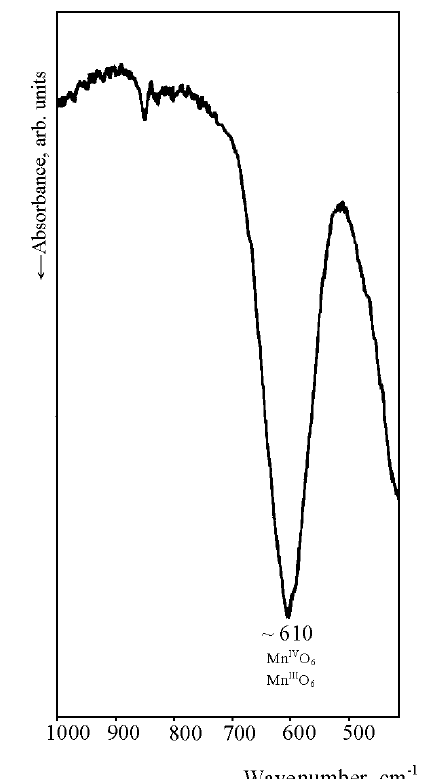
Fig. 6 IR-spectrum (1000-400 cm − 1 ) of the final product, obtained after heating of the complex LaMn(Cl)Cit-120 for 2.5 h at 1000 ◦